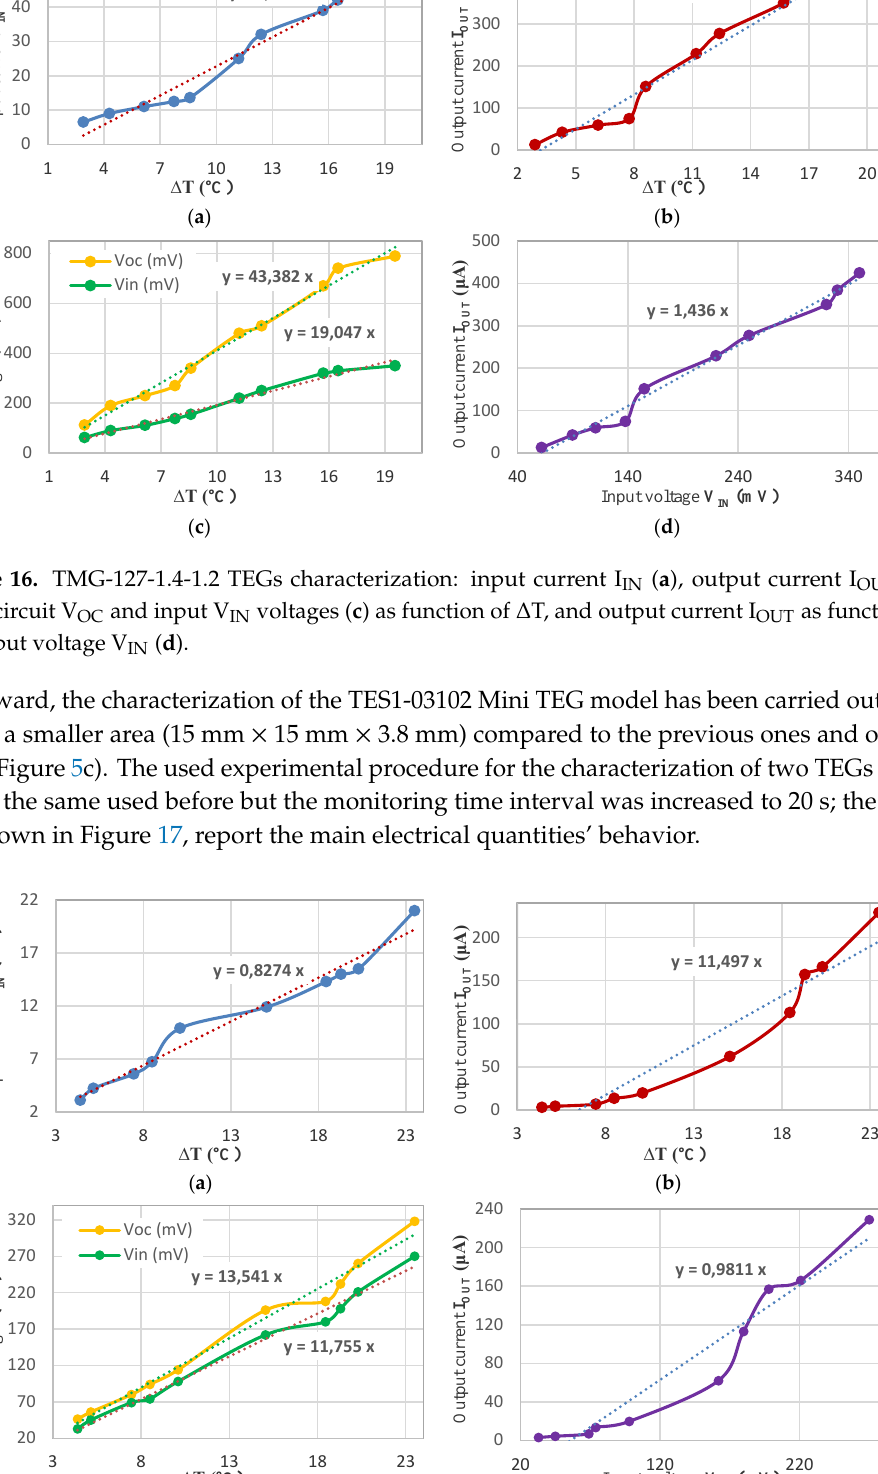
Figure 17. TES1-03102 Mini TEGs characterization: input current I IN ( a ), output current I OUT ( b ), open-circuit V OC and input V IN voltages ( c ) as function of ΔT, and output current I OUT as function of the input voltage V IN ( d ).